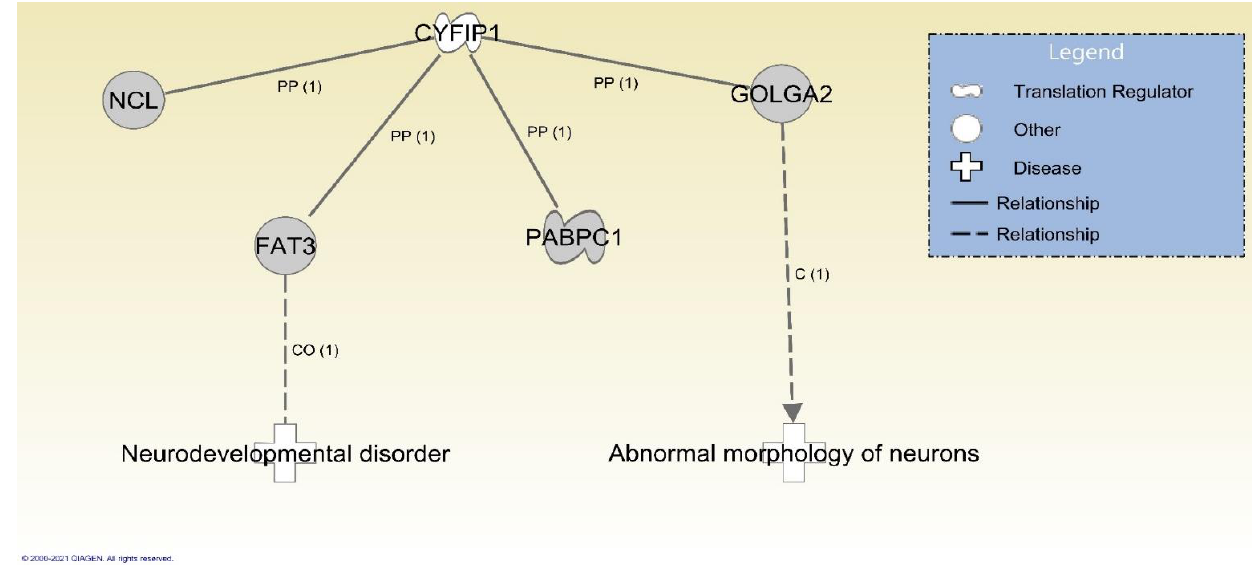
Figure 4. Genes with variants transmitted from non-deleted parents to affected children with evidence for downstream relationships with CYFIP1 . Shown are genes prioritized following Ingenuity Pathway Analysis of all genes with variants in affected children that were inherited from parents without the 15q11.2 BP1-BP2 microdeletion that were also evidenced to be involved in the etiology of diseases relevant to symptoms observed in affected children. Included are protein–protein interactions (PP) and diseases and functions where variation in the gene is causal (C) or correlated (CO).